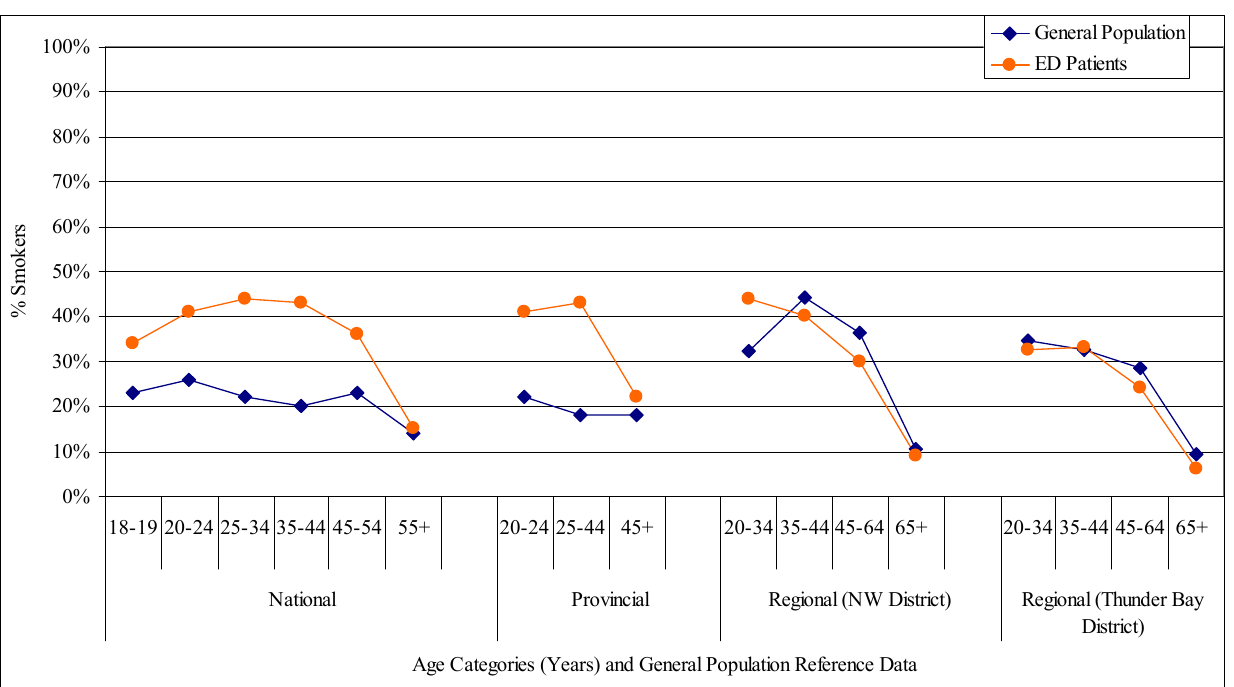
Figure 2. Comparison of Tobacco Use Prevalence between the ED Population and the National, Provincial, and Regional General